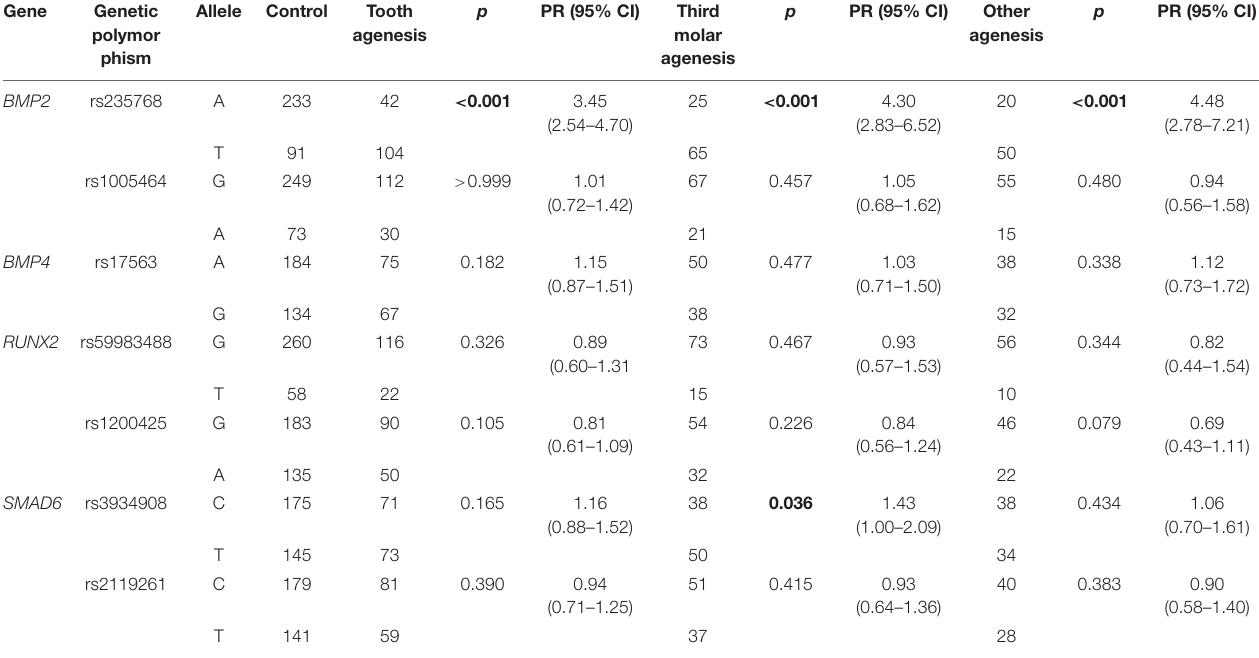
TABLE 2 | Allelic distribution between groups.